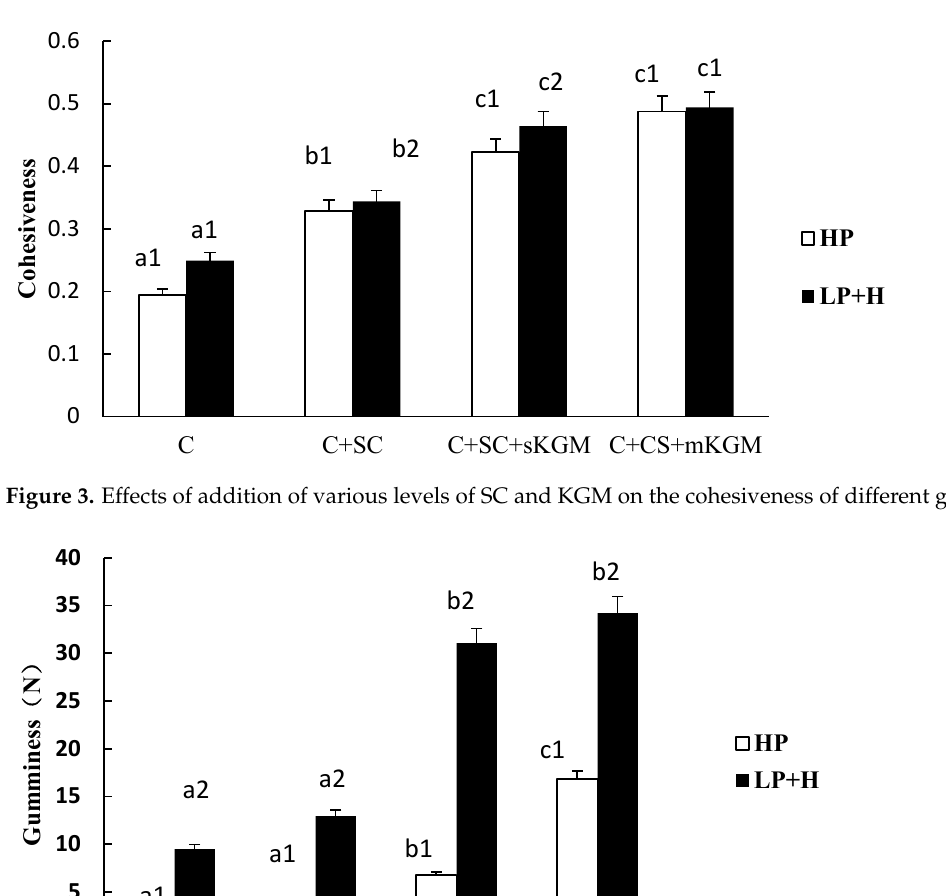
Figure 2. Effects of addition of various levels of SC and KGM on the springiness of different gels.